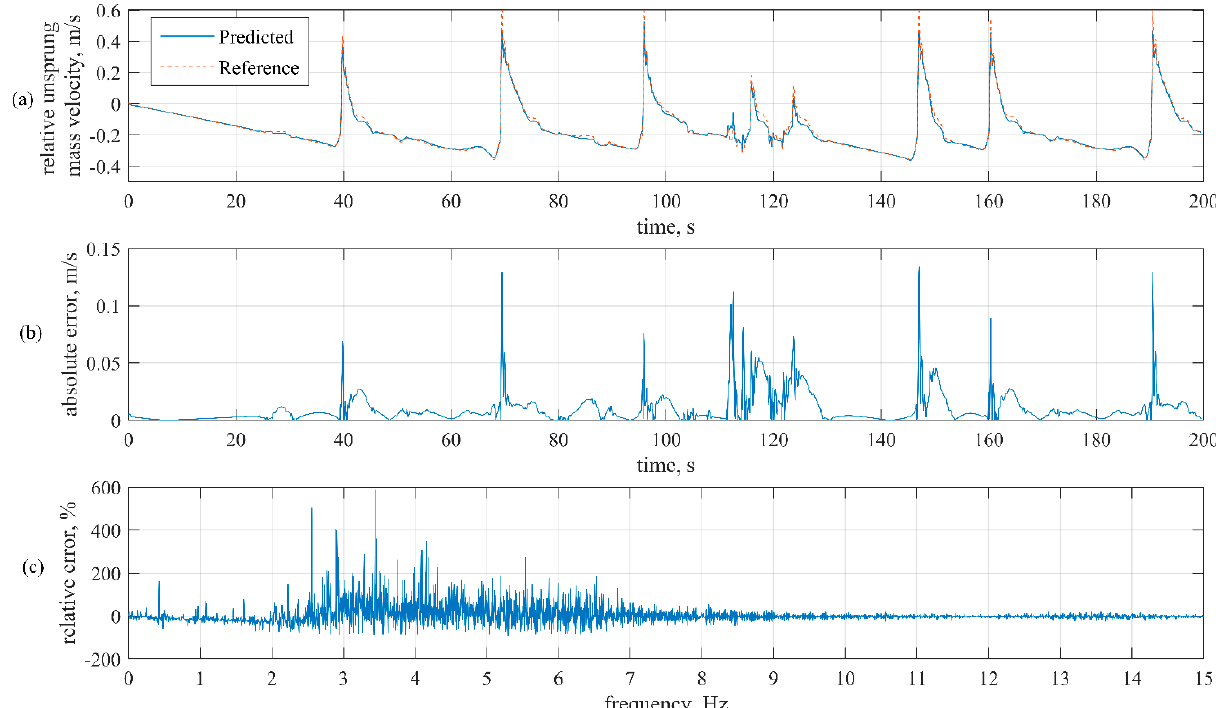
Figure 7. Comparison of predicted and reference signal: ( a ) time-domain graph of reference and predicted signal; ( b ) time-domain graphs of absolute error of predicted signal compared to reference; ( c ) relative error of frequency spectrum of a predicted signal.